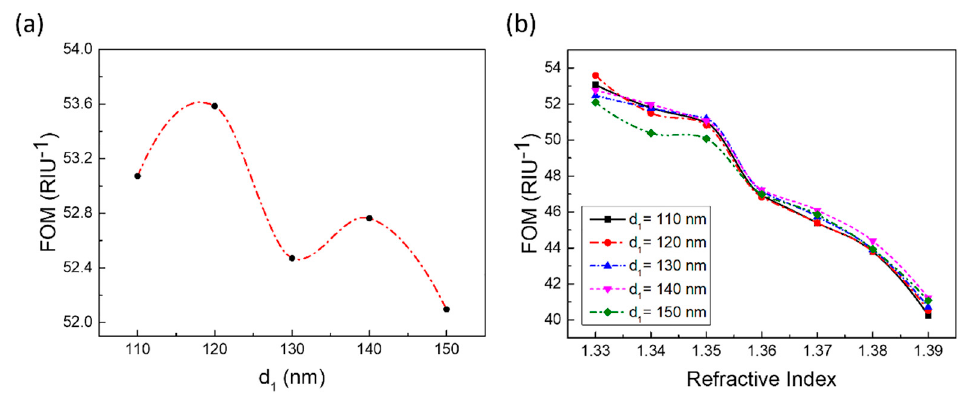
Figure 6. FOM change with the thickness of metal film or environmental refractive index ( n ). ( a ) FOM change with d 1 @ n = 1.33. ( b ) FOM change with environmental refractive index @ n = 1.33~1.39 and d 1 = 110~150 nm. (The solid line and dashed line connecting the data points is simply connected with a smooth curve for readers as a guide for an eye.).